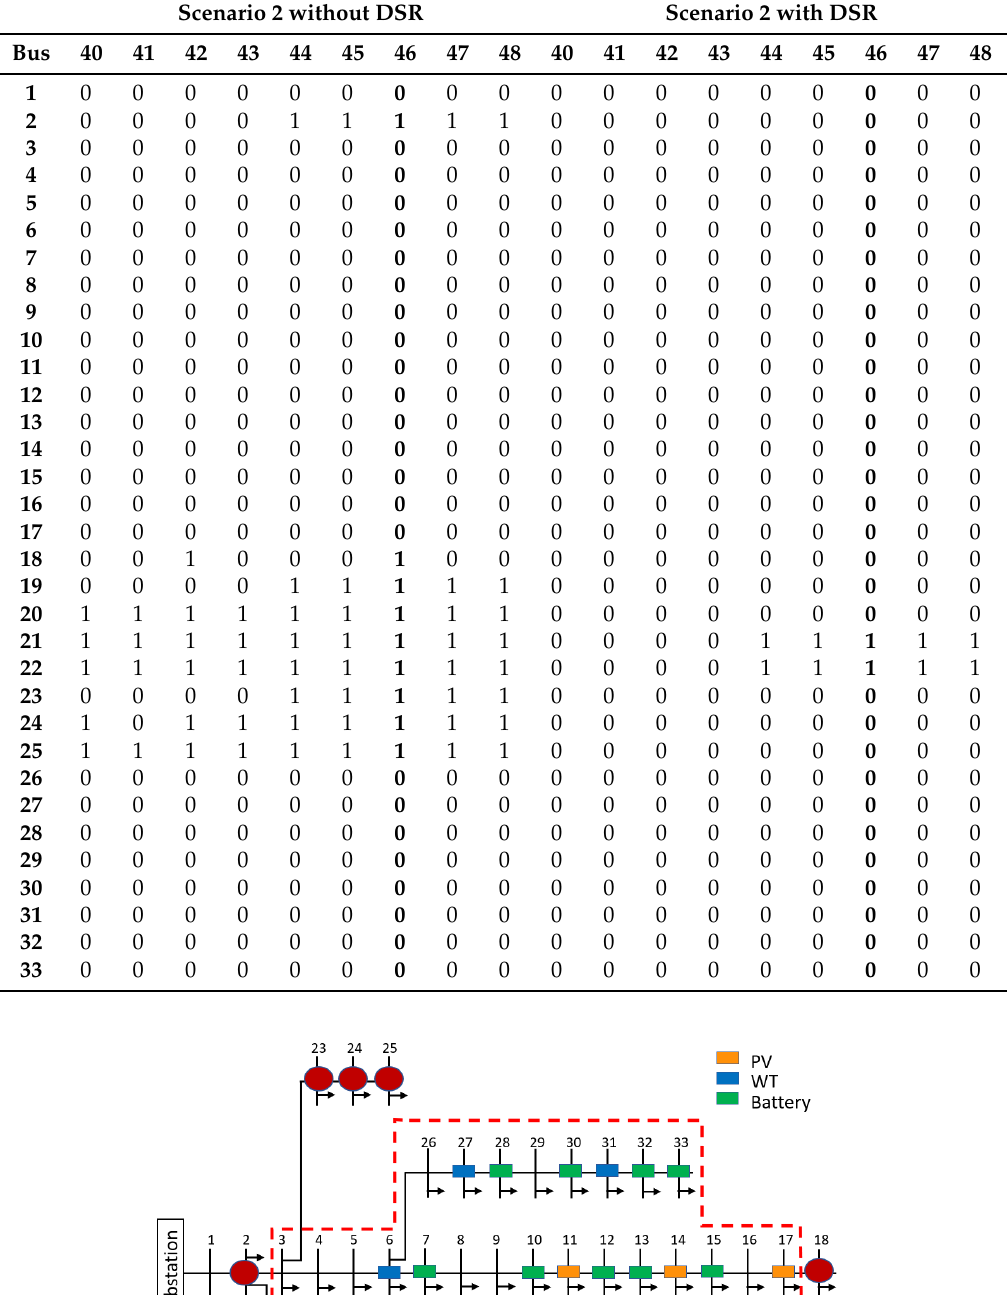
Table 4. DN topology under the second scenario.